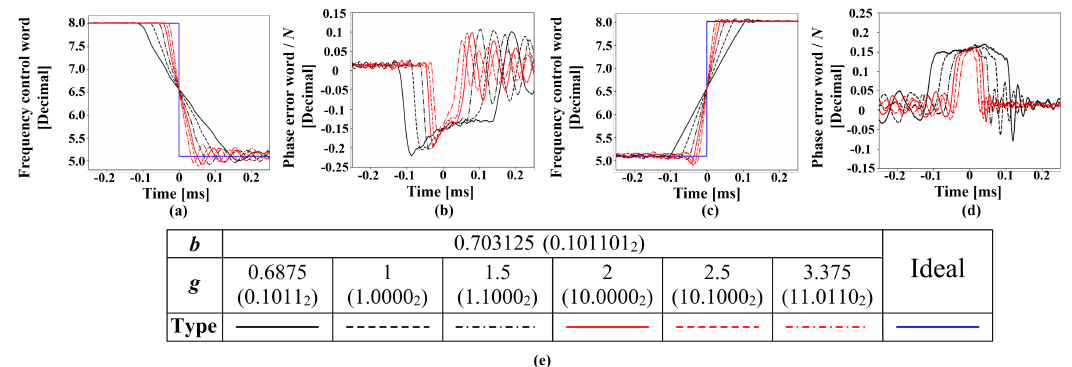
Figure 12. Measured step response with b value fixed: ( a , b ) frequency control code and detected phase error code for falling input frequency step, ( c , d ) those for rising input frequency step, ( e ) the legend for each parameter. The timing in code variations is shifted so as to have the same 50% transition point of the frequency control code. The frequency control code is also shifted up to match the DCO input